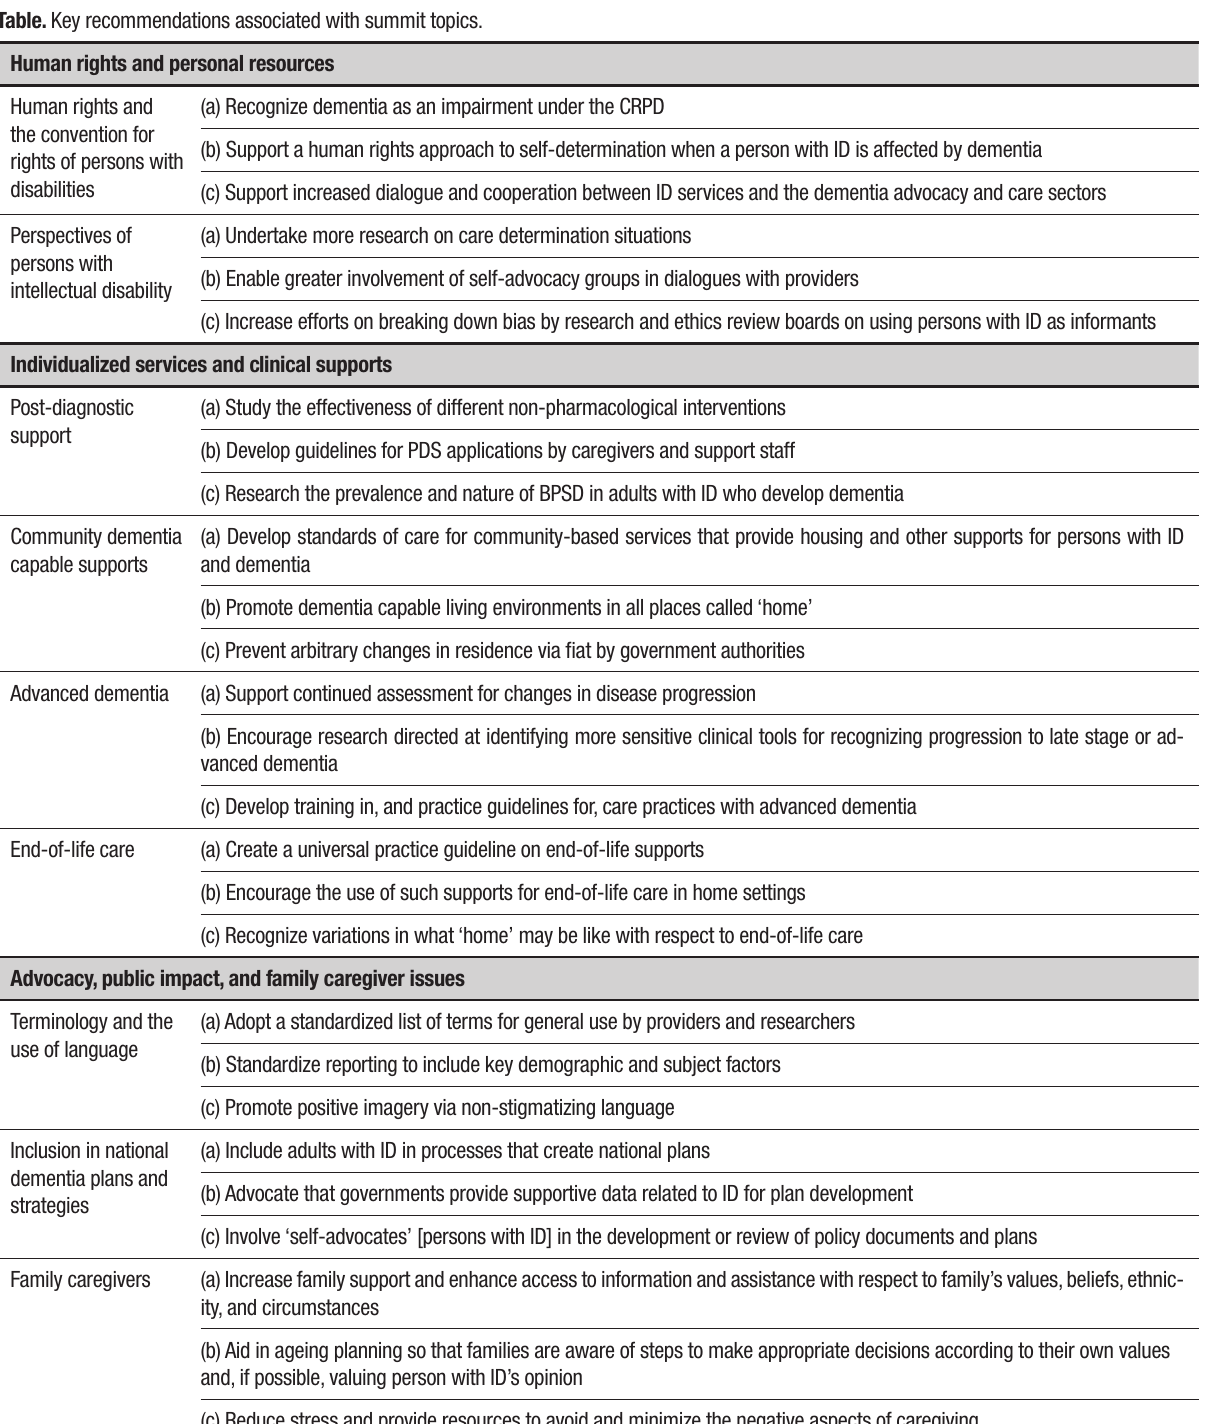
Table. Key recommendations associated with summit